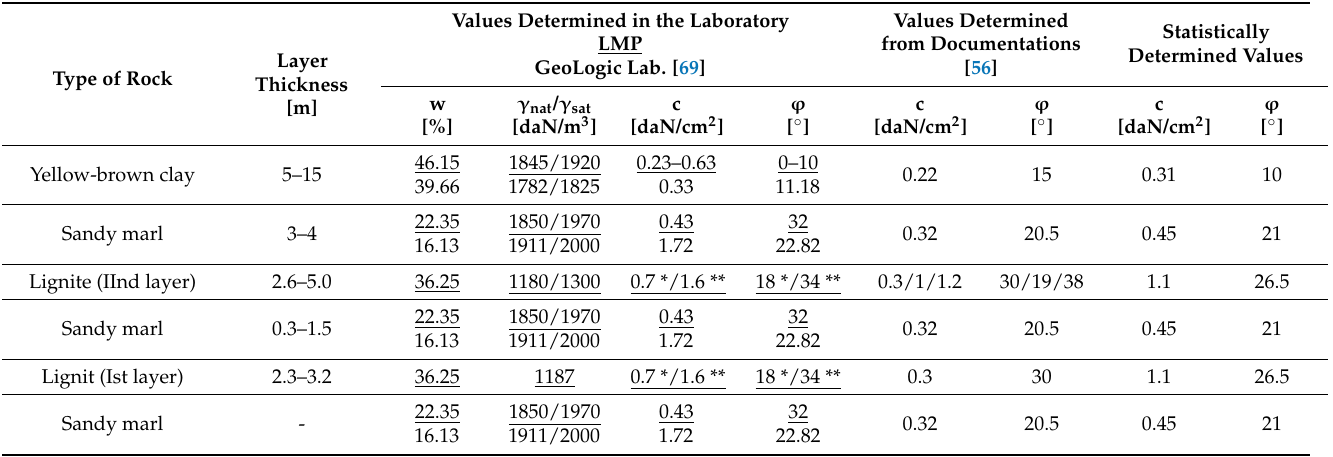
Table 1. Physical–mechanical properties of the